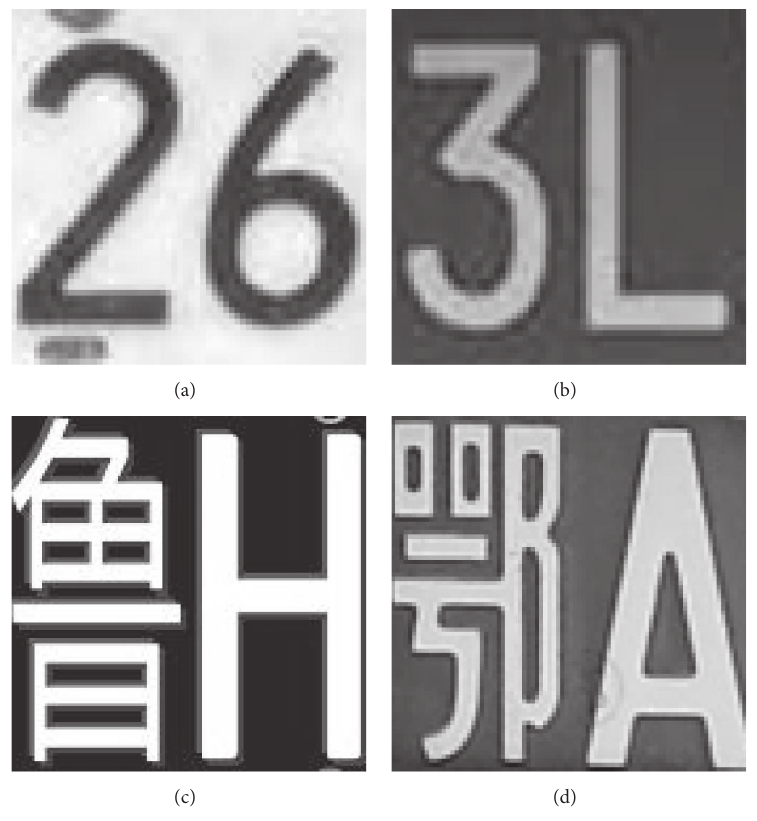
Figure 2: Four test